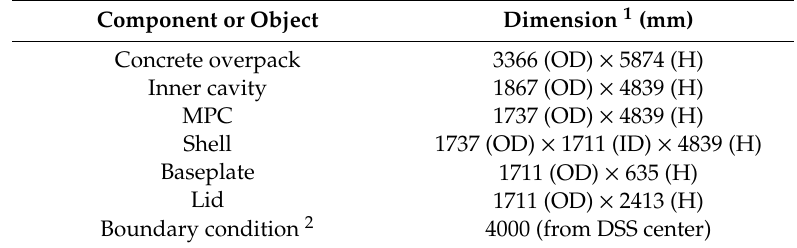
Figure 4. Geometrical model of the HI-STORM 100 DSS developed for the MCNP calculation. Table 3. Geometrical and dimensional characteristics of the HI-STORM 100 DSS together with the boundary conditions [16].